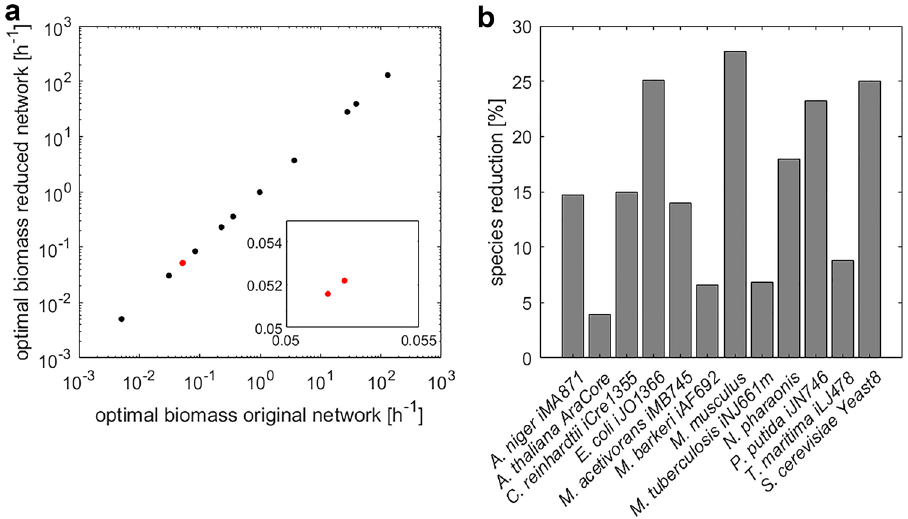
Figure 4. Prediction of specific growth rate in original and reduced models. For direct comparison it is ensured that metabolites that comprise the biomass reaction in the original model remain in the reduced model. ( a ) Specific growth rate estimated from the original and reduced models assuming arbitrary kinetics. The red marked data point are two overlapping points, as shown by the inlay on a smaller scale. ( b ) Model reduction on the level of